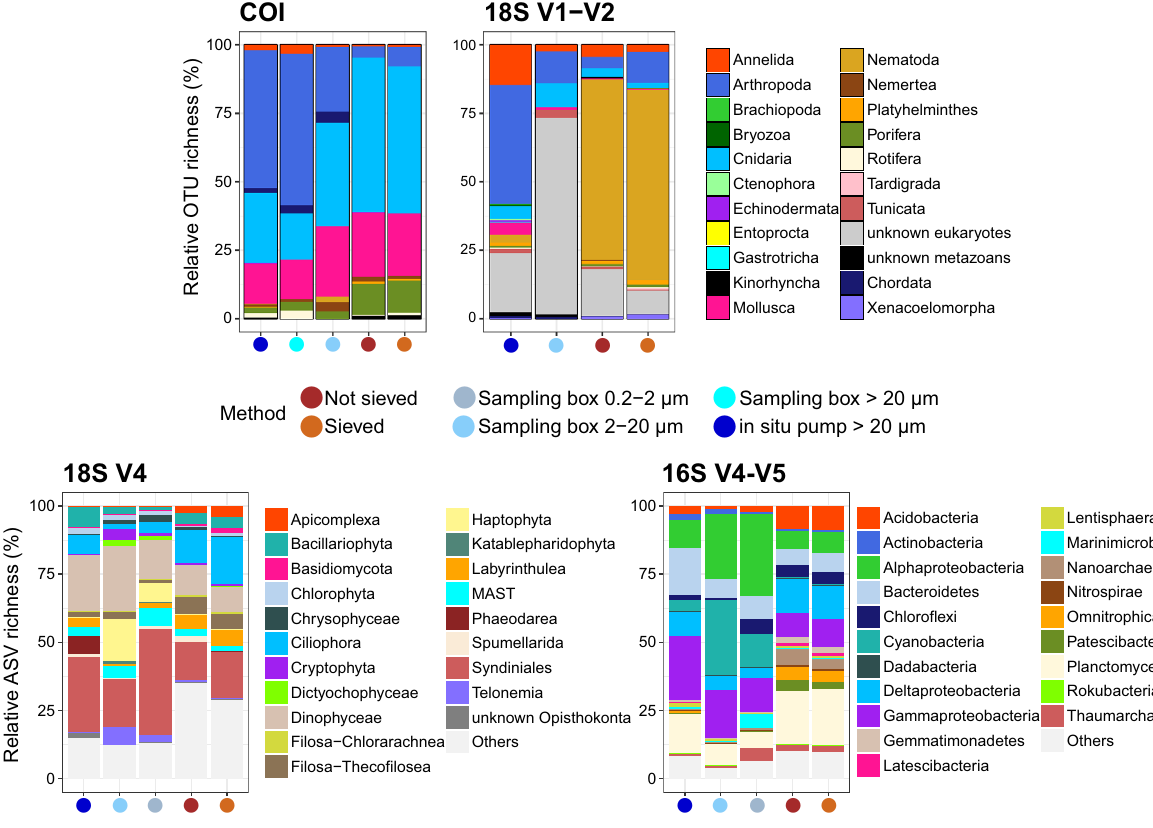
Figure 3. Patterns of relative cluster abundance resolved by eDNA metabarcoding of deep-sea sediment (brown) and aboveground water (blue), using two sampling methods for both sample types, and using four barcode markers targeting metazoans (COI, 18S V1–V2), micro-eukaryotes (18S V4), and prokaryotes (16S V4–V5). Sediment was either sieved to size-sort organisms prior DNA extraction, or DNA was extracted directly from crude sediment samples. Water was collected with a 7.5 L sampling box, allowing recovery of up to two size classes per taxonomic compartment, or sampled in large volumes with an in situ pump. Top 20 most abundant taxa are displayed for microbial